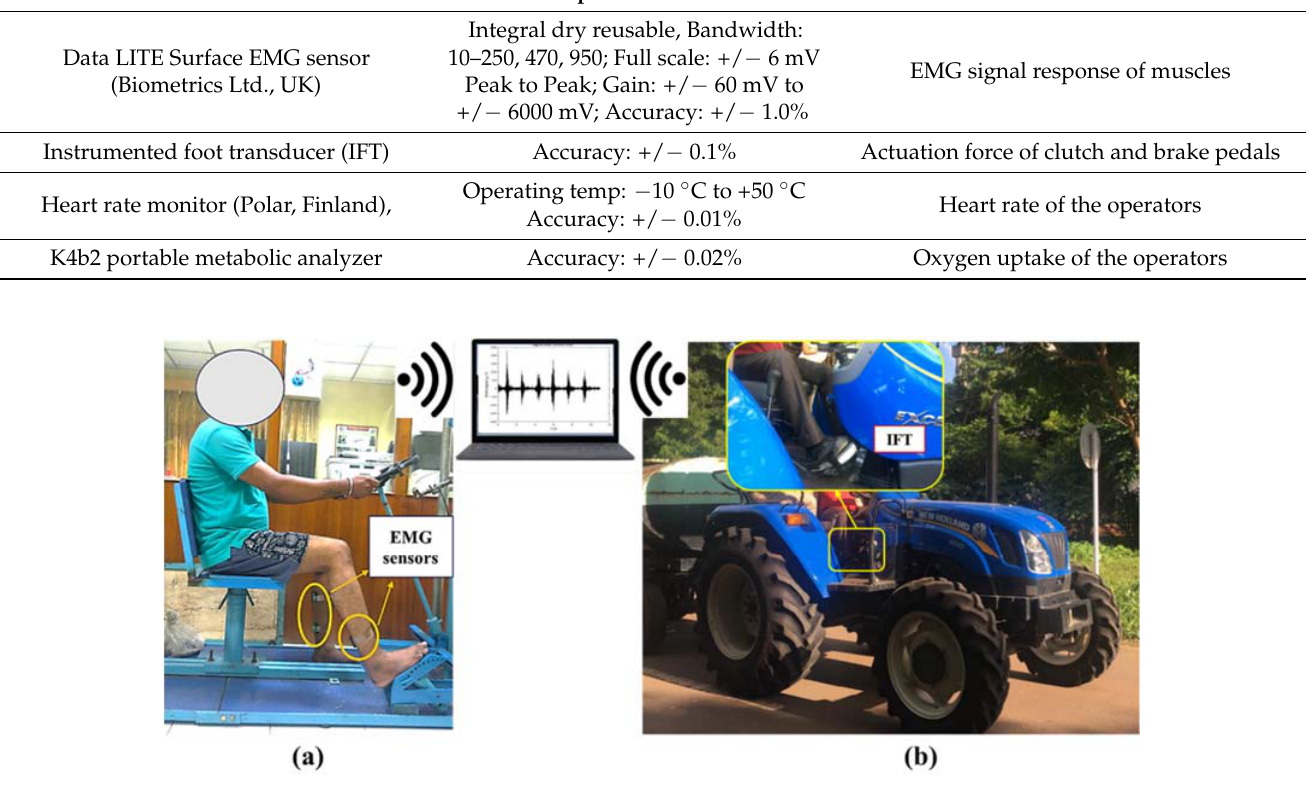
Figure 1. Operator electromyography and load measurement on ( a ) strength measurement setup, and ( b ) during tractor clutch and brake operation. Table 2. Sensor and instrumentation specifications used in the study.